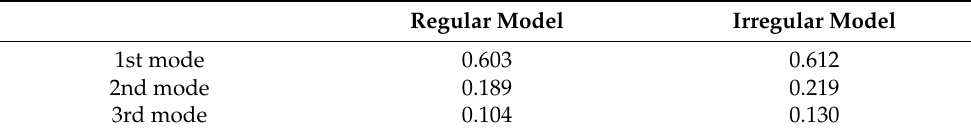
Table 5. Modal mass participation ratios of regular and irregular building models. Regular Mode